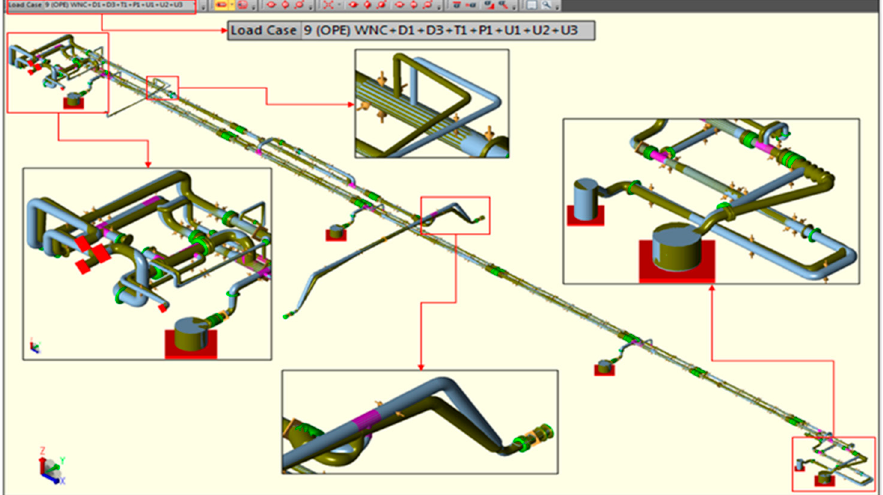
Figure 8. Maximum stress of pipeline.